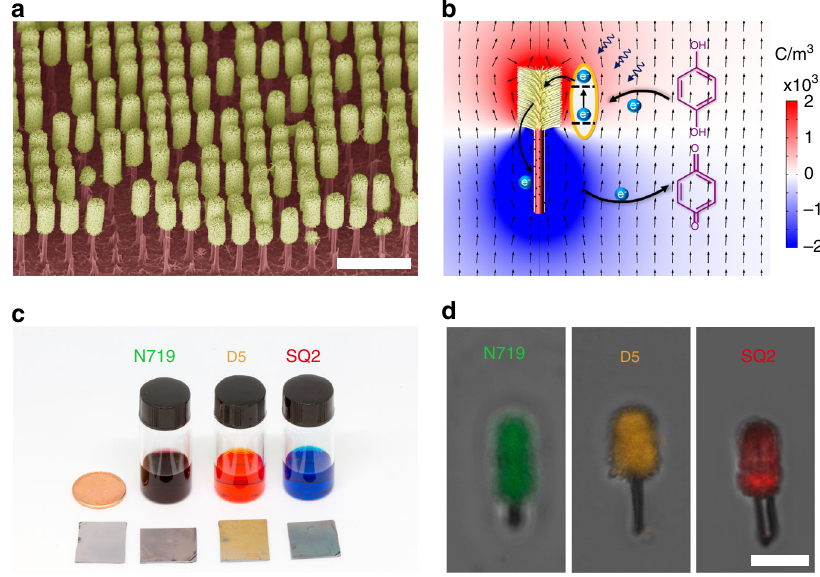
Fig. 1 Schematic diagram and structural characterizations of the microswimmers. a False-colored scanning electron microscope image of the dye-sensitized Janus nanotree with TiO 2 nanowire branches and silicon nanowire trunk (scale bar: 10 μ m). b Schematic diagram of the dye-sensitized microswimmer driven by photoelectrochemical reaction with the numerically simulated charge distribution (color map). The length of the arrow is normalized and does not represent the fl ow magnitude. c The photograph of the dye alcoholic solutions and the corresponding dye-sensitized nanotree samples. d The confocal fl uorescence mapping images of the dye-sensitized microswimmers, which show that all three dyes are selectively loaded onto the TiO (scale bar: 5 μ